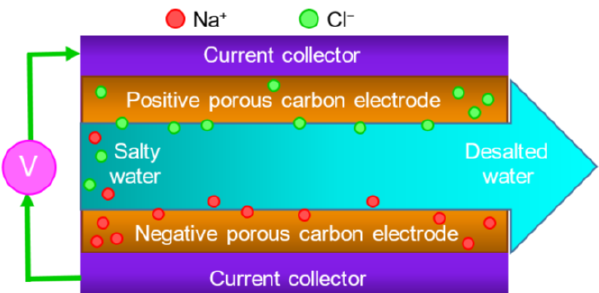
Figure 24. Schematic illustration of the capacitive deionization (CDI) of water (inspired by reference [189]). Salty water is inlet into the CDI cell, Na + (Cl − ) ions are adsorbed on the negative (positive) porous carbon electrode, and the as-obtained desalted water goes out.